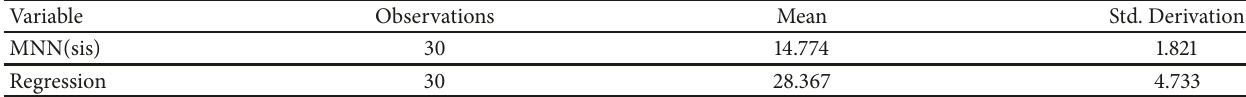
Table 12: Descriptive statistics Module 3 (pulse).